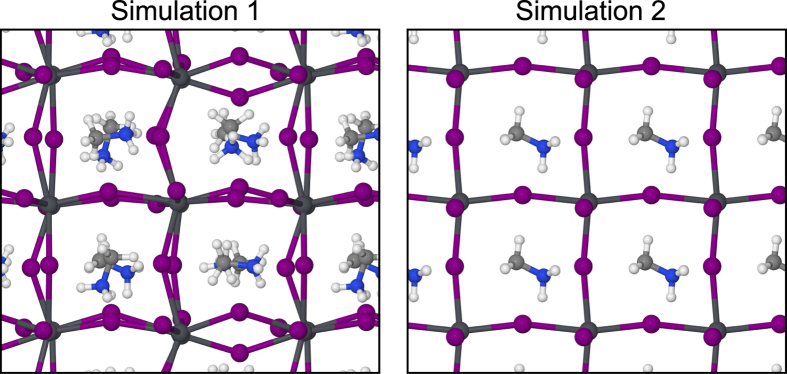
Initial configurations for the two Car-Parrinello simulations, based on (2 × 2 × 2) cubic supercells of CH3NH3PbI3.